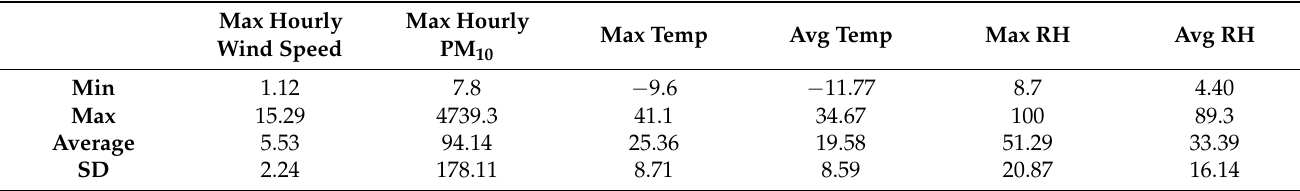
Table 2. Descriptive analysis of maximum hourly wind speed (m/s), maximum hourly PM 10 ( µ g/m 3 ), maximum and average temperature ( ◦ C), maximum and average relative humidity (%) at TCEQ CAMS 12, El Paso, TX, 2010–2014.